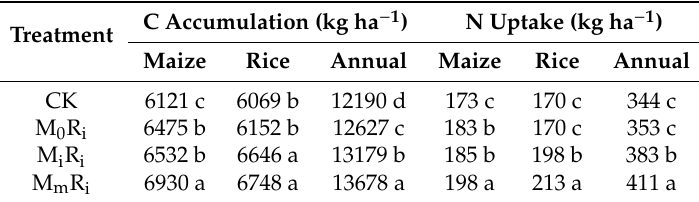
Table 4. C accumulation and N uptake of maize and rice crops with di ff erent straw incorporation treatments in